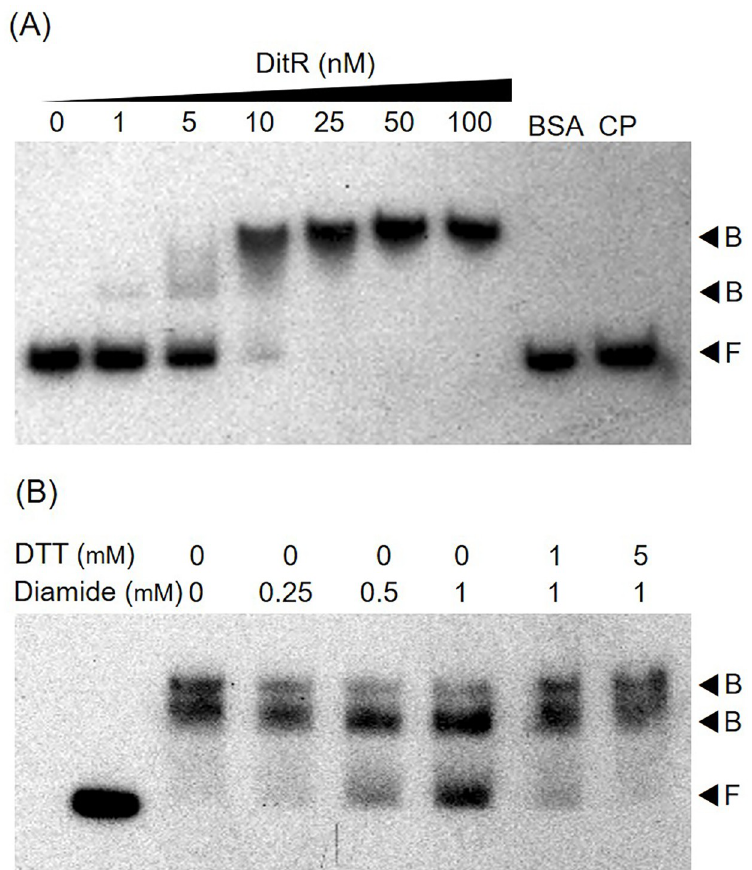
Fig 7. Binding of purified DitR to mfsBC promoter. (A) EMSA was performed using increased amounts of purified DitR (0–100 nM) and a 32 P-labeled 204-bp mfsBC promoter region. BSA and CP signify unrelated protein bovine serum albumin (500 μ M) and cold probe, which is an unlabeled mfsBC promoter fragment (100 ng). (B) EMSA experiments were repeated using 50 nM of DitR. After the binding reaction was completed, the mixtures were treated with the indicated concentrations of diamide (0–1 mM). In the DTT-treated experiments, the binding reaction was treated with 1 mM diamide prior to being treated with 1 and 5 mM DTT. Free (F) and bound (B) probes are marked by